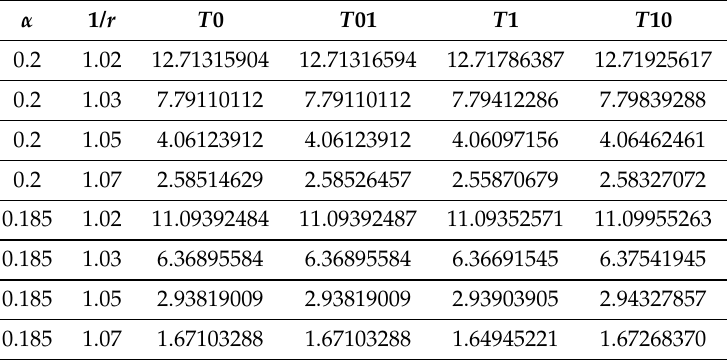
Table 2. Selection of numerical